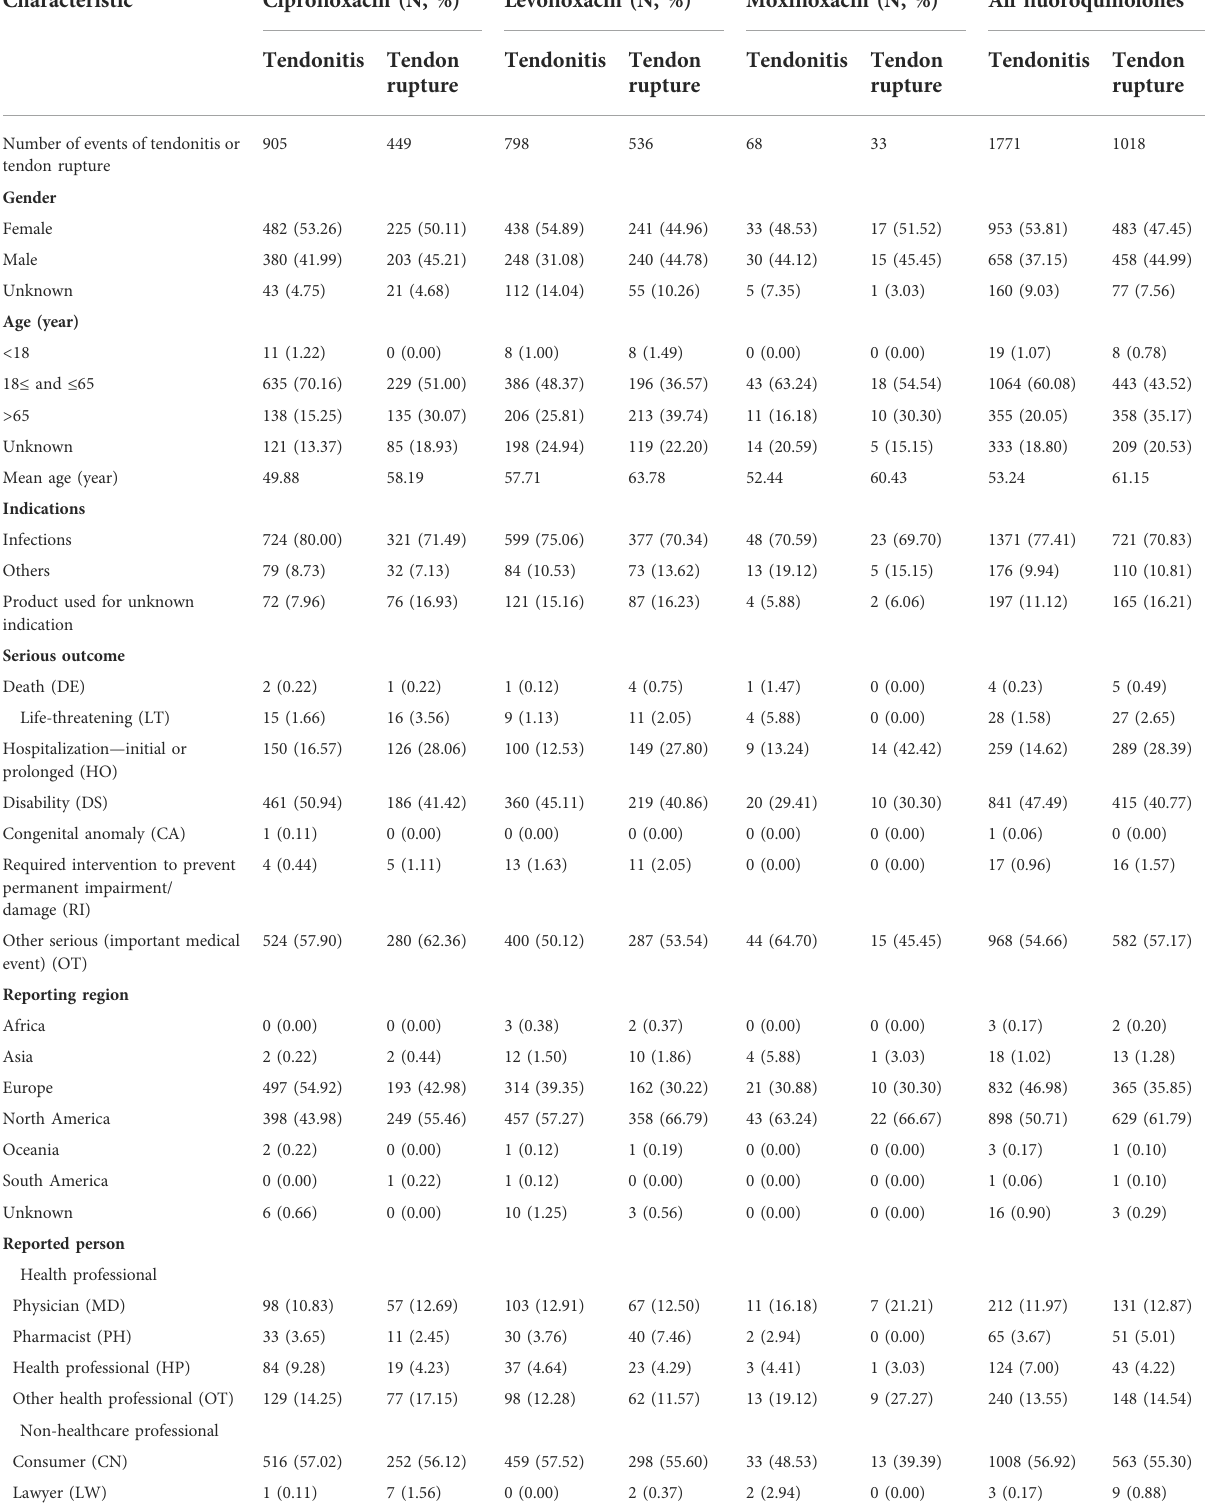
TABLE 1 Clinical characteristics of reports with cipro fl oxacin-, levo fl oxacin-, and moxi fl oxacin-associated tendonitis and tendon rupture from the FAERS database (January 2016 to March 2021). Characteristic Cipro fl oxacin (N, %) Levo fl oxacin (N, %) Moxi fl oxacin (N, %) All fl uoroquinolones Tendonitis Tendon Tendonitis Tendon Tendonitis Tendon Tendonitis Tendon rupture rupture rupture rupture Number of events of tendonitis or tendon